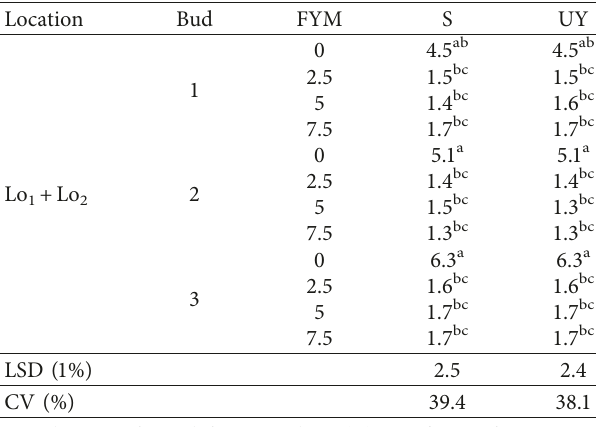
Table 3: Some yield and quality components of head cabbage as influenced by the interaction effects of bud number and farmyard manure